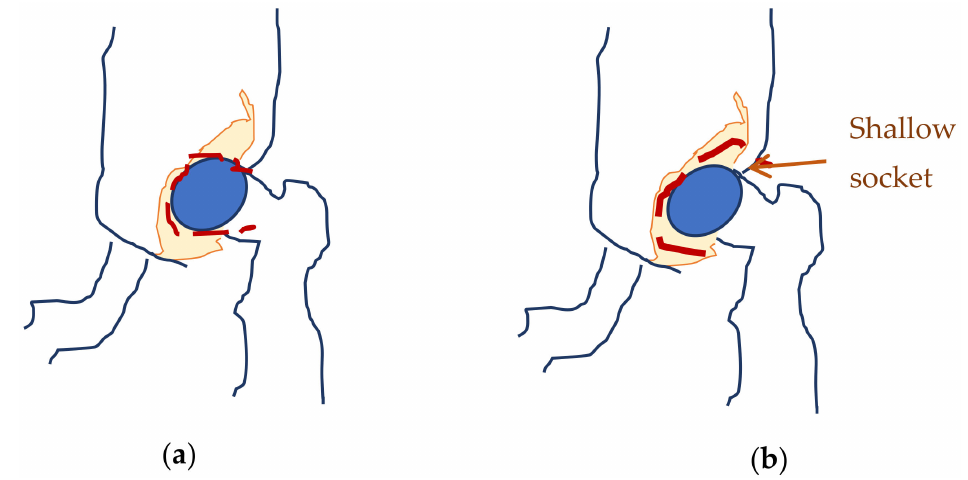
Figure 1. Normal hip ( a ) and hip dysplasia ( b ) in